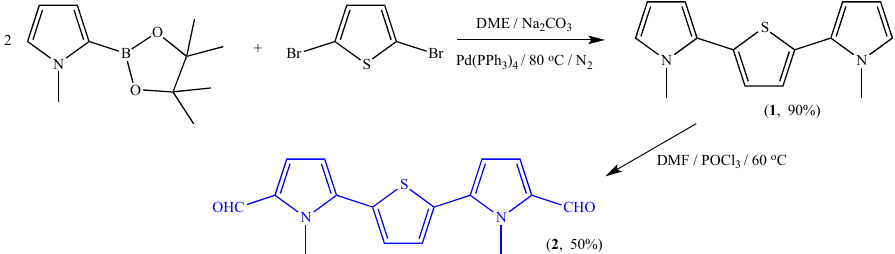
Scheme 1. Pyrrole precursors ( 1–2 ) synthesis by Suzuki-Miyaura coupling and Vilsmeier formylation, formylation, respectively. respectively.